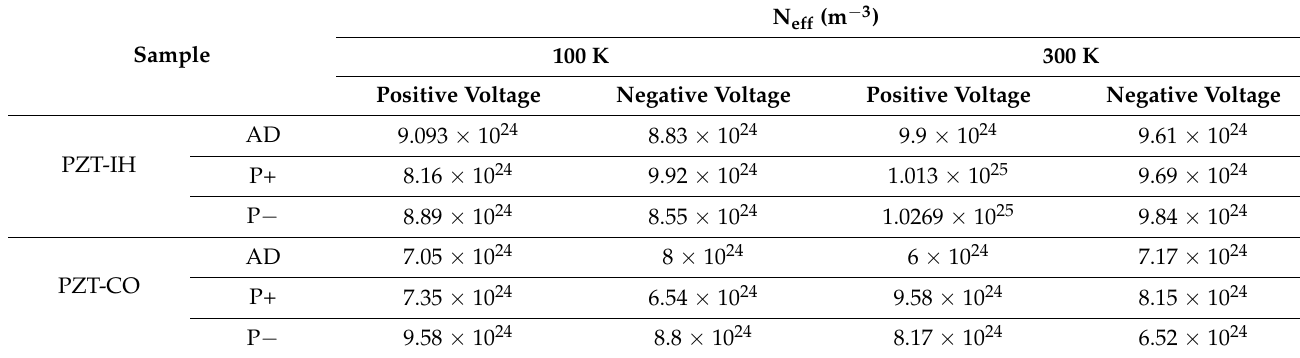
Table 1. The effective density of charges N eff extracted from the C–V characteristics recorded at different temperatures (similar to a metal-semiconductor Schottky contact, can be considered as the density of charge in the depleted region [41,42]).